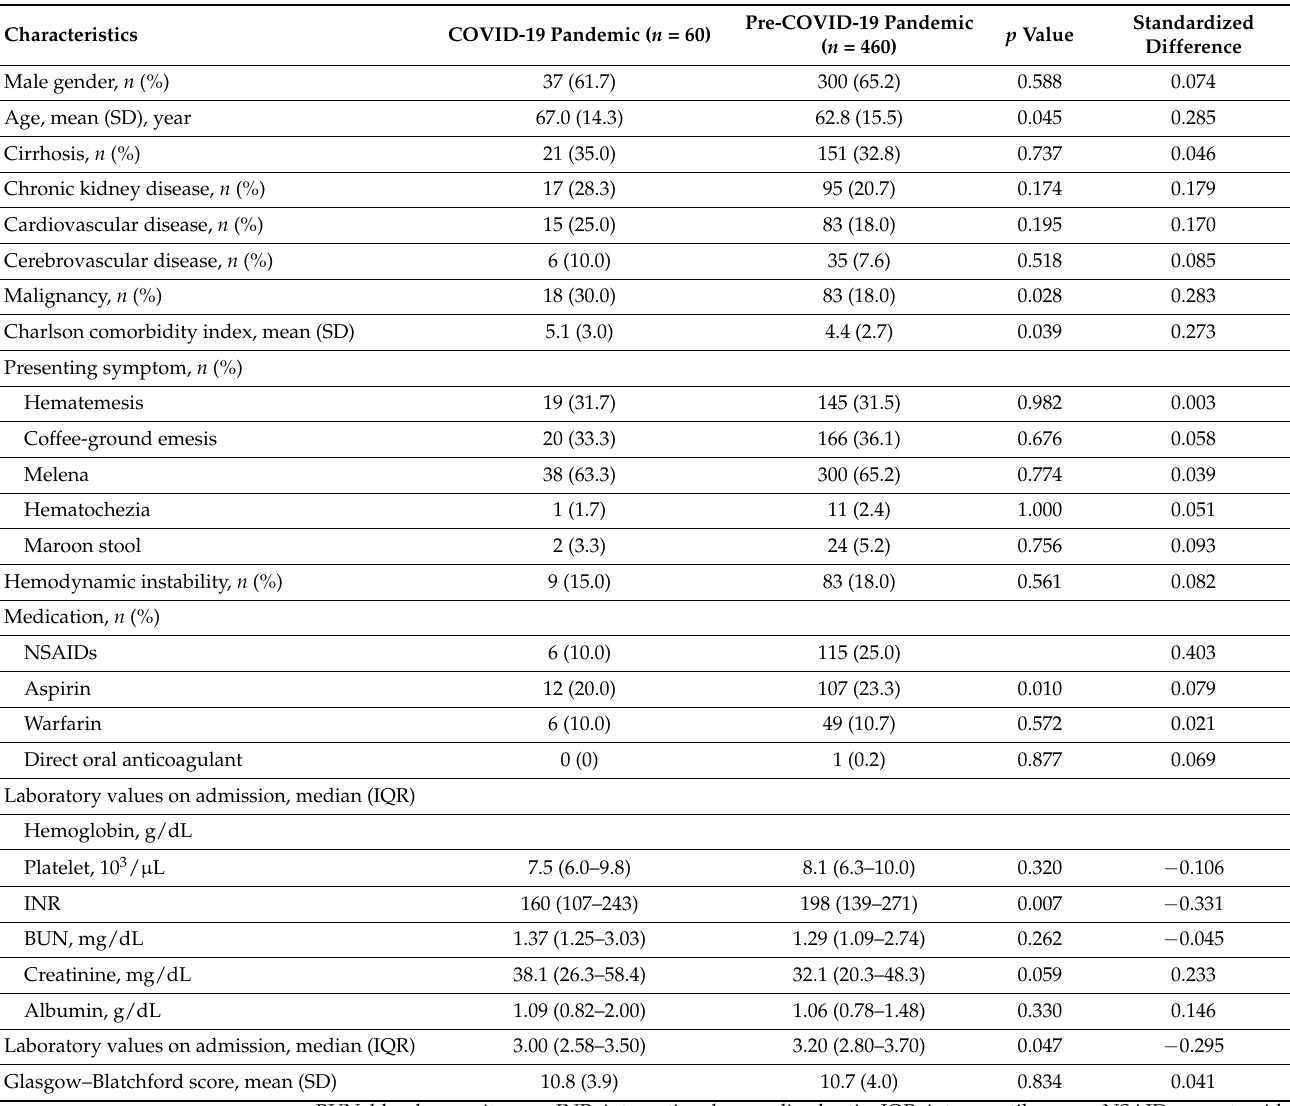
Table 1. Baseline characteristics of the overall population.